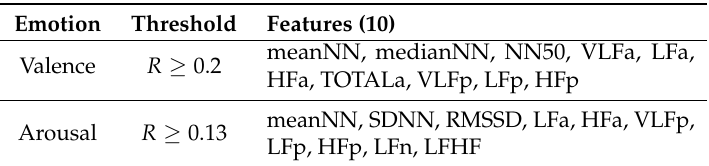
Table 3. Selected statistical